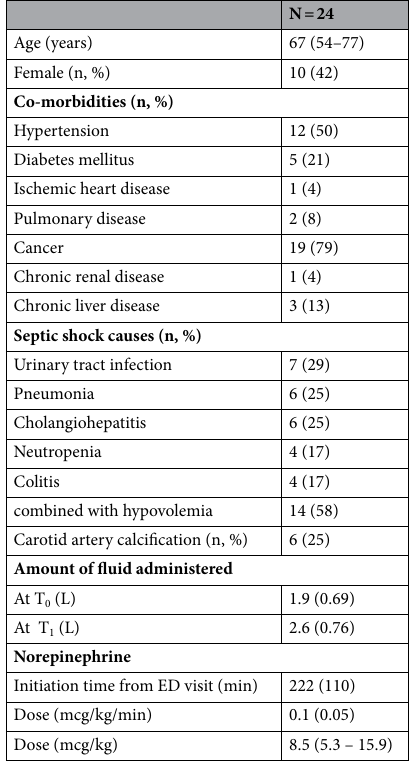
Table 1. Baseline characteristics of patients. T 0, time before initiation of norepinephrine; T 1, time after initiation of norepinephrine; ED, emergency department. Data are presented as mean (standard deviation) and median (interquartile range).